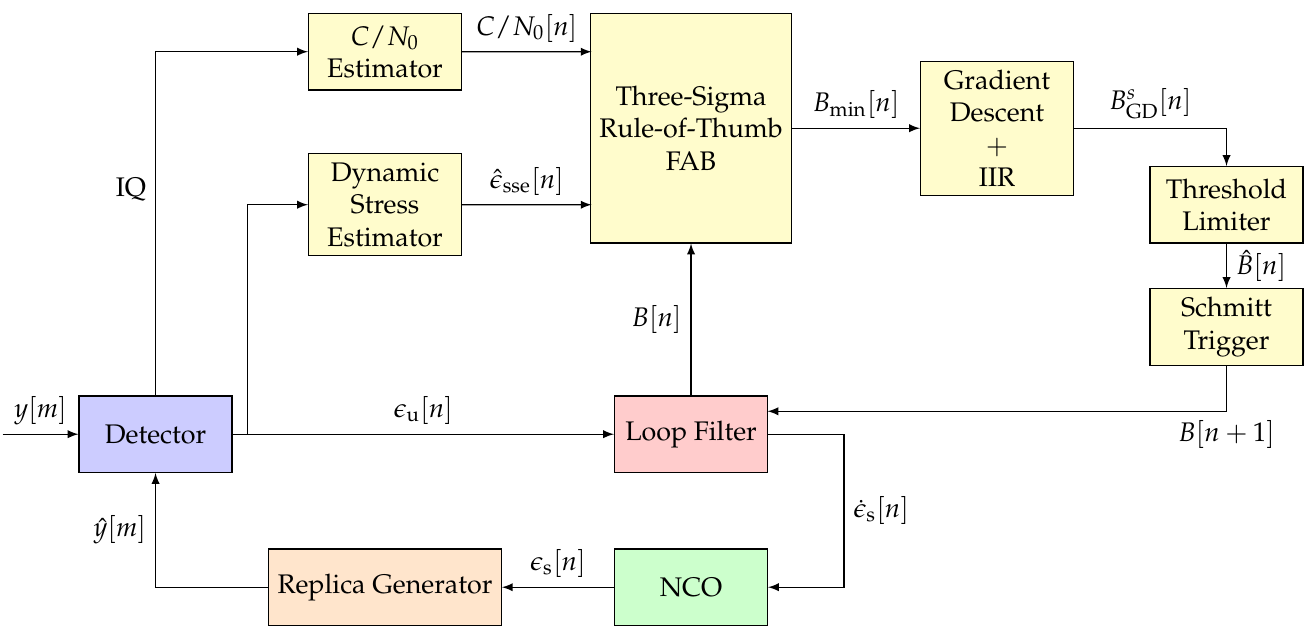
Figure 6. Architecture of the three-sigma rule-of-thumb based Fast Adaptive Bandwidth (FAB). ©IEEE. Adapted, with permission, from